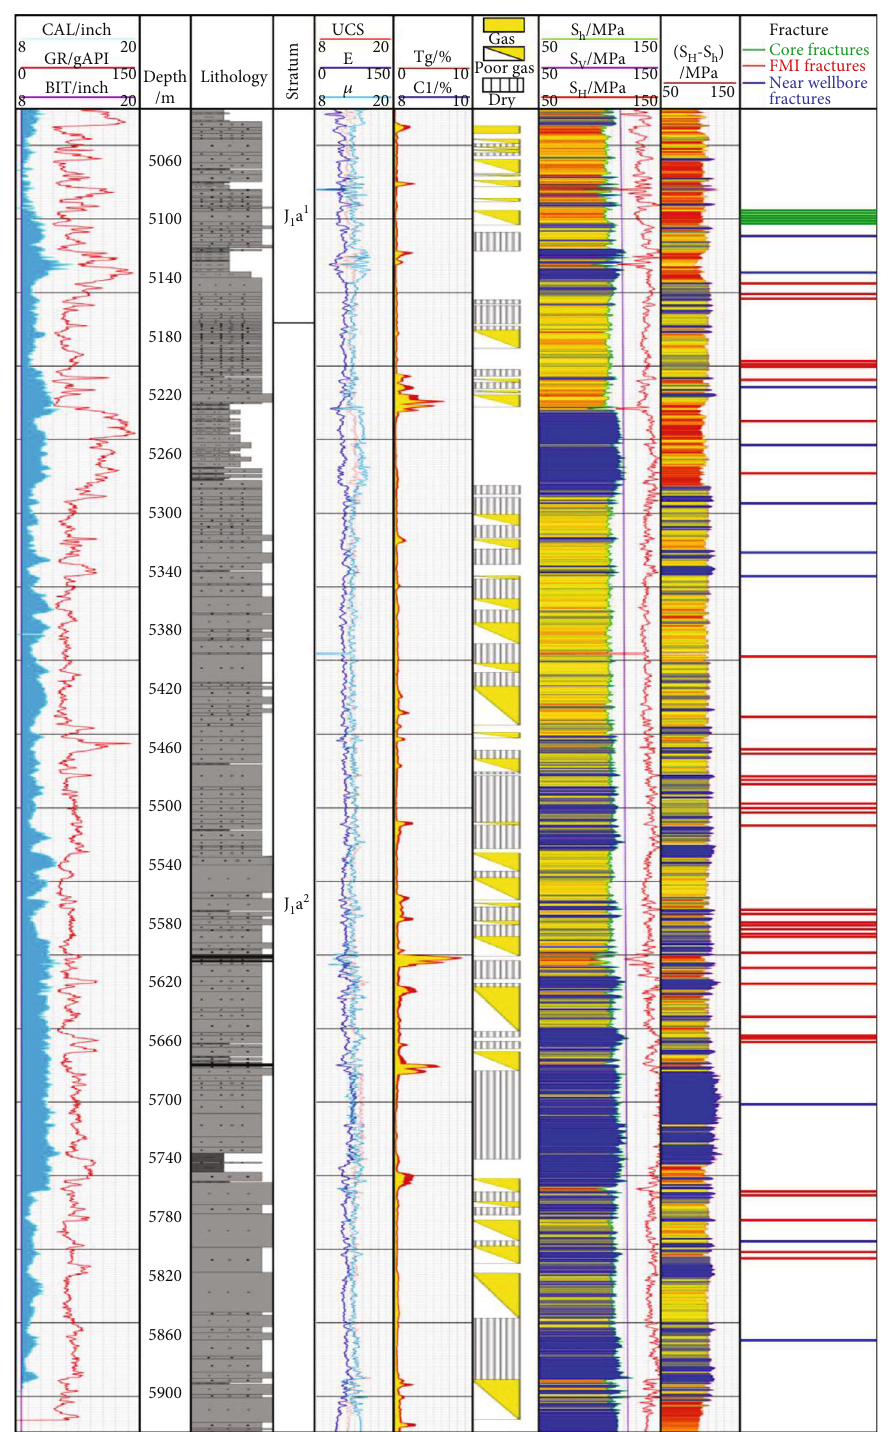
Figure 17: Geomechanical histogram of Well